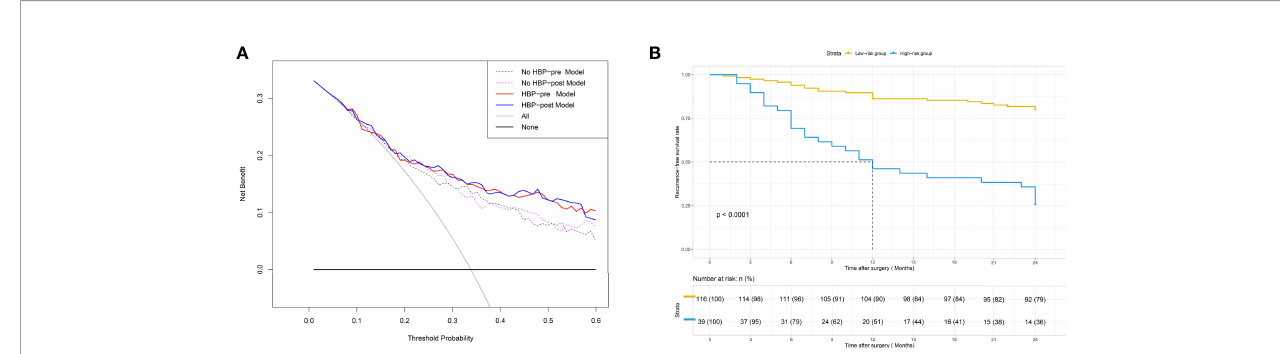
FIGURE 5 | (A) DCA for four models. The use of the four nomograms for early recurrence prediction provides more bene fi t than two extreme conditions [the treat- all-patients scheme (gray line) and the treat-none scheme (horizontal black line)]. Nomograms of the HBP-pre model (red line) and the HBP-post model (blue line) received a higher net bene fi t than the model based on the No HBP-pre model (black dotted line) and the No HBP-post model (purple dotted line) when the threshold probability was greater than 25%. DCA = decision curve analysis. (B) Patients were strati fi ed by the risk scores calculated with the HBP-pre model. The recurrence- free survival rate (RFS) of each group was calculated, and signi fi cant differences in each risk group were observed by the Log-rank test ( p <